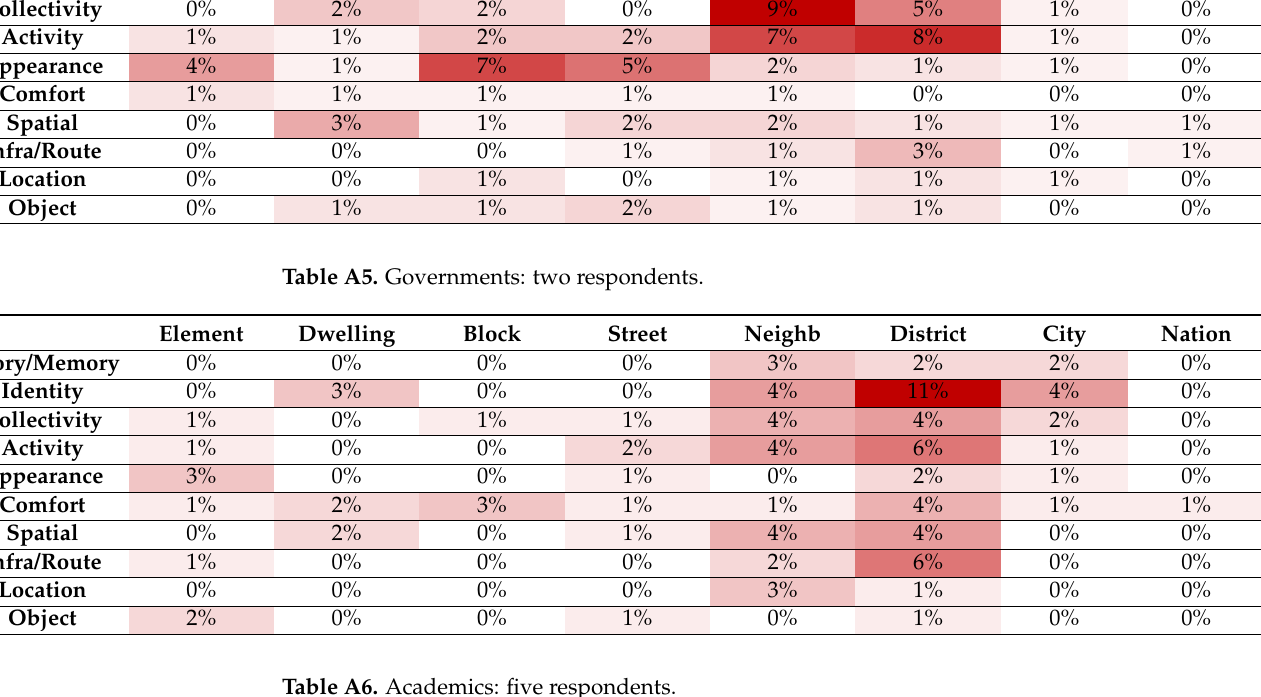
Table A6. Academics: five respondents.